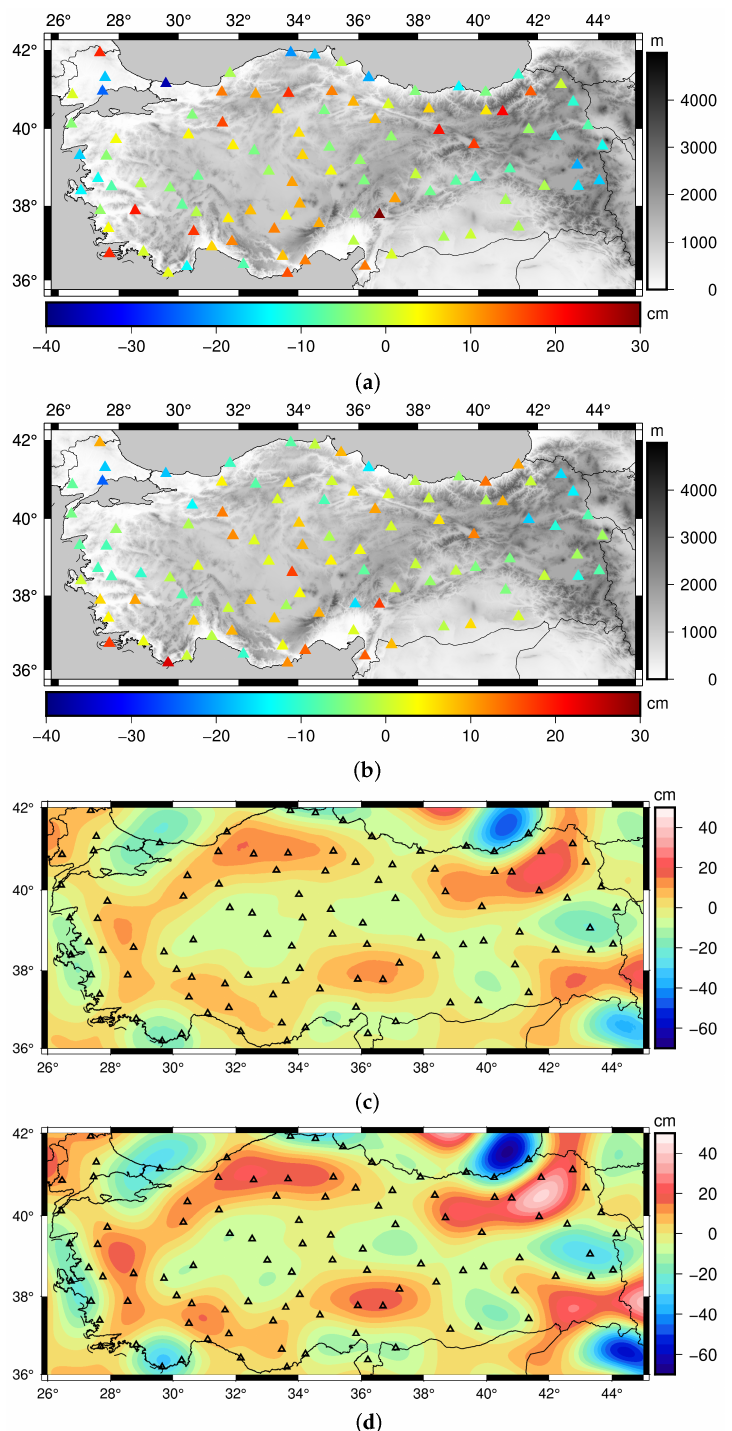
Figure 7. Residual geoid heights of ( a ) gravimetric geoid model computed with EGM2008 (expGeoid − 4) at GNSS/leveling stations and ( b ) gravimetric geoid model computed with TIM − R6/EGM2008 mixed GGM (expGeoid − 6) at GNSS/leveling stations. Differences between expGeoid − 4 and expGeoid − 6 ( N expGeoid − 6 − N expGeoid − 4 ) are given in ( c ) where the statistics are: Minimum = − 49.8 cm, Maximum = 25.0 cm, Mean = − 1.6 cm, SD = 9.3 cm. The long wavelength geoid height differences computed using TIM − R6 and EGM2008 GGMs at 204 degree/order are given in ( d ) where the statistics are: Minimum = − 67.0 cm, Maximum = 47.7 cm, Mean = − 1.0 cm, SD = 13.9